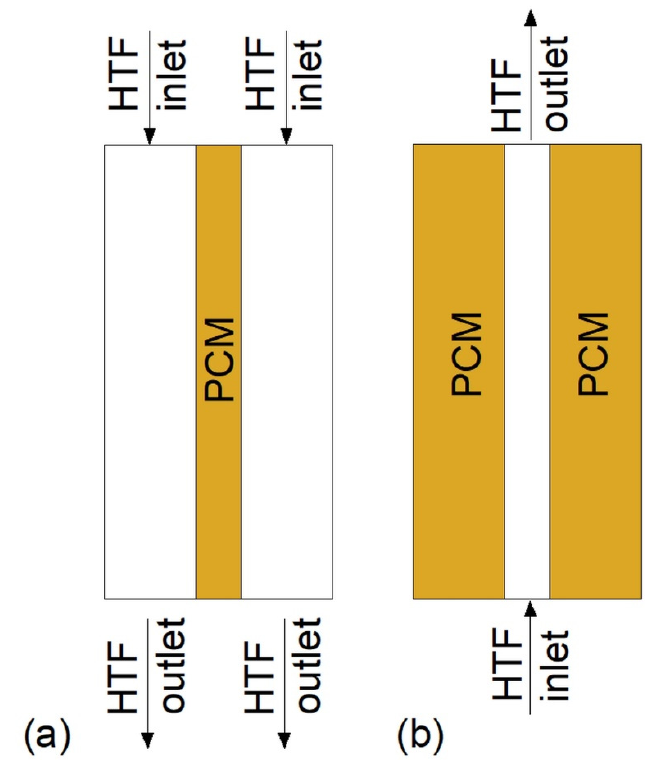
Figure 5. Vertical double-tube HX: ( a ) Cylinder model with downward HTF flow direction, ( b ) pipe model with upward HTF flow direction.